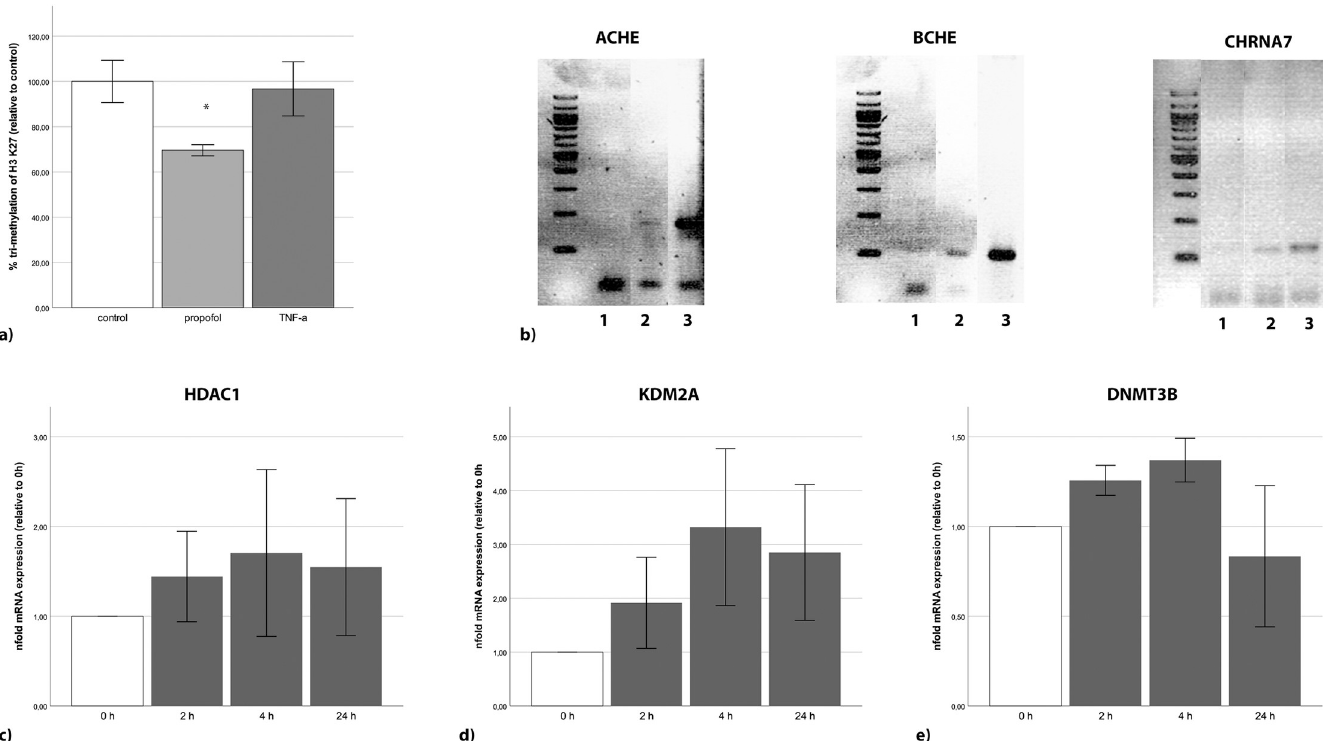
Fig 4. Unspecific changes in the epigenome by propofol. ( a ) The tri-methylation of H3 K27 in SH-SY5Y cells was significantly decreased by propofol [25 μ g/ml], while TNF α [10 ng/ml] did not show any changes after 24 h. ( b ) ChIP assays showed that the promoter regions of ACHE , BCHE and CHRNA7 bind to tri-methylated H3 K27. For the negative control (1) rabbit IgG was used instead of the specific tri met H3 K27 antibody (2), and the positive control contained an antibody against RNA polymerase and primers for GAPDH. ( c ) Propofol increased the expression of the histone de-acetylating HDAC1 approximately 1.5-fold. ( d ) The expression of KDM2A was increased more than 3-fold after 4h, and ( e ) the expression of DMNT3B was slightly increased over the first 4 hours. Error bars depict 2 x